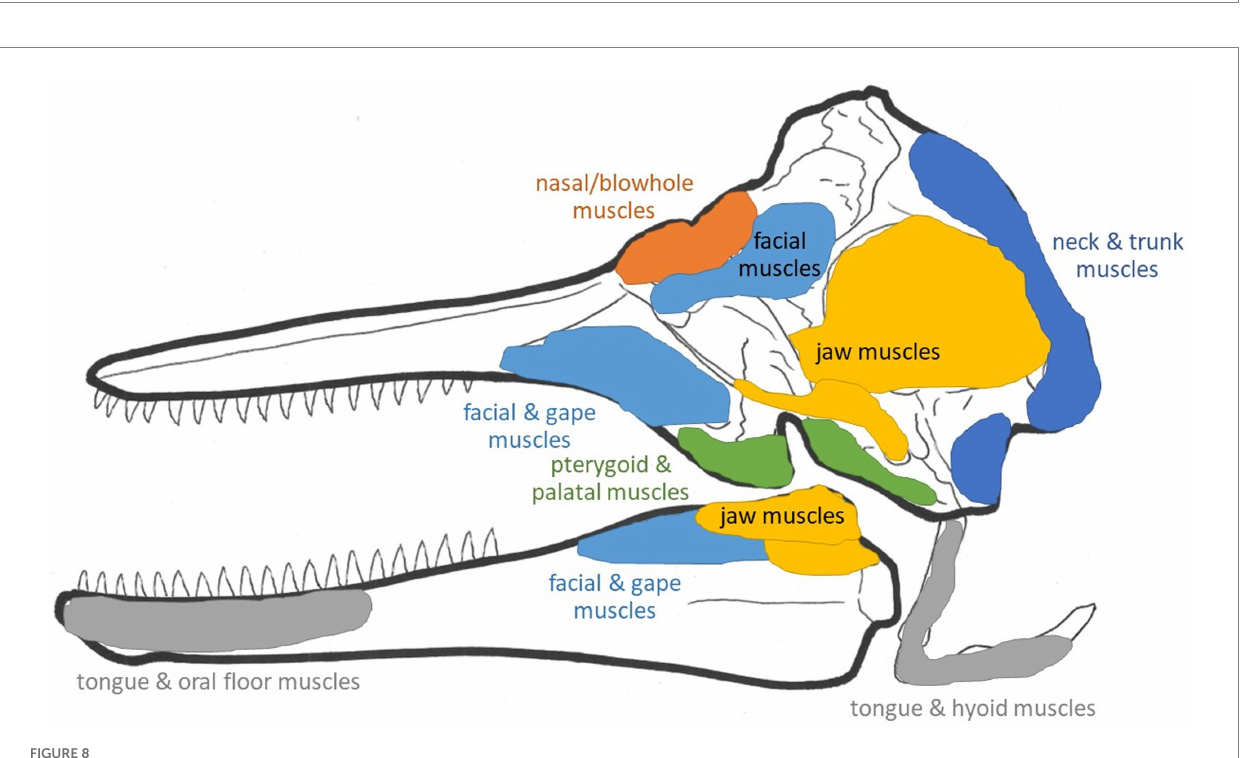
FIGURE 8 Schematic general muscle groups and attachment sites in a Recent odontocete